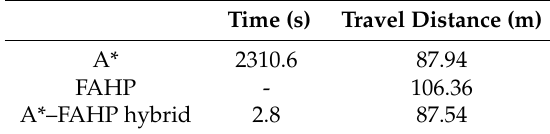
Table 3. Comparison of path planning performance.